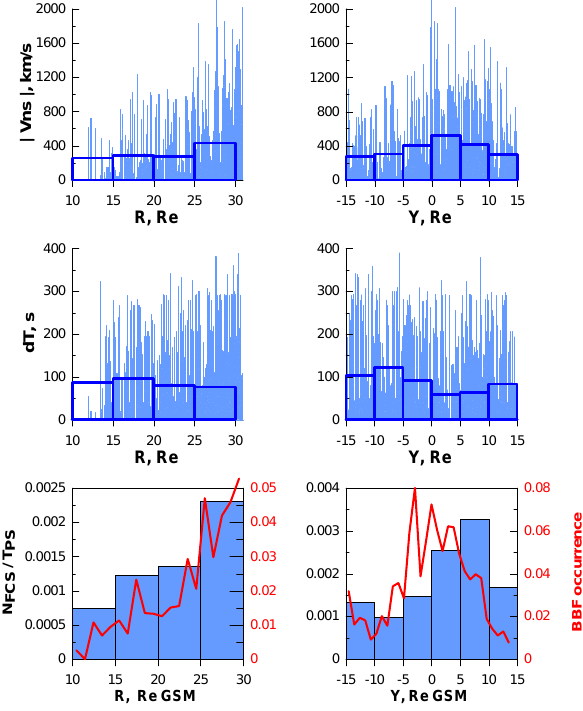
Fig. 5. Dependence of neutral sheet flows, duration of CS crossing and occurrence frequency of flapping events against the distance from the Earth ( R = (x 2 + y 2 ) 1 / 2) and across the tail (Ygsm). The flapping occurrence is normalized to a total number of minutes of observation spent by the spacecraft in that spatial bin. Occurrence rate of fast plasma flows (with | V x | > 400km/s) is shown for com- parison in the two bottom panels.